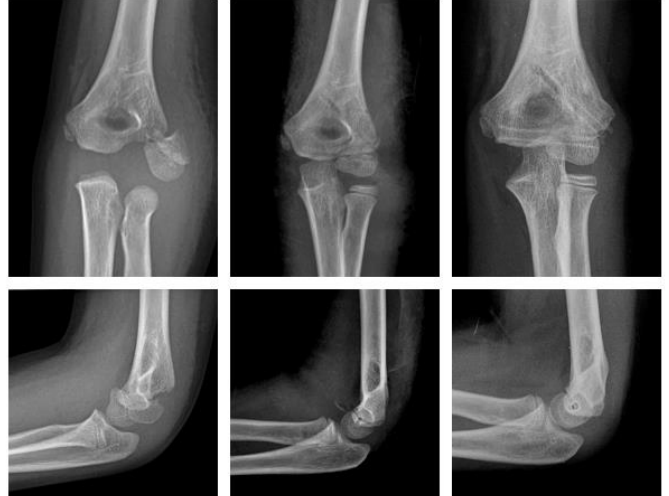
Figure 6. Fracture of the lateral condyle with ActivaPin TM : preop, 1 week postop, 6 months postop (left to right).